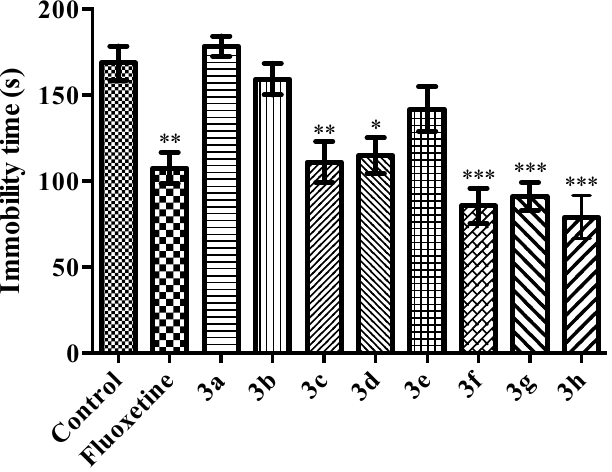
Figure 1. The effects of the test compounds 3a – 3h (40 mg/kg) and fluoxetine (20 mg/kg) on the immobility time of the mice in TST. Significant differences versus control values, * p < 0.05, ** p < 0.01, *** p < 0.001. Values are given as mean ± SEM, (n = 6).